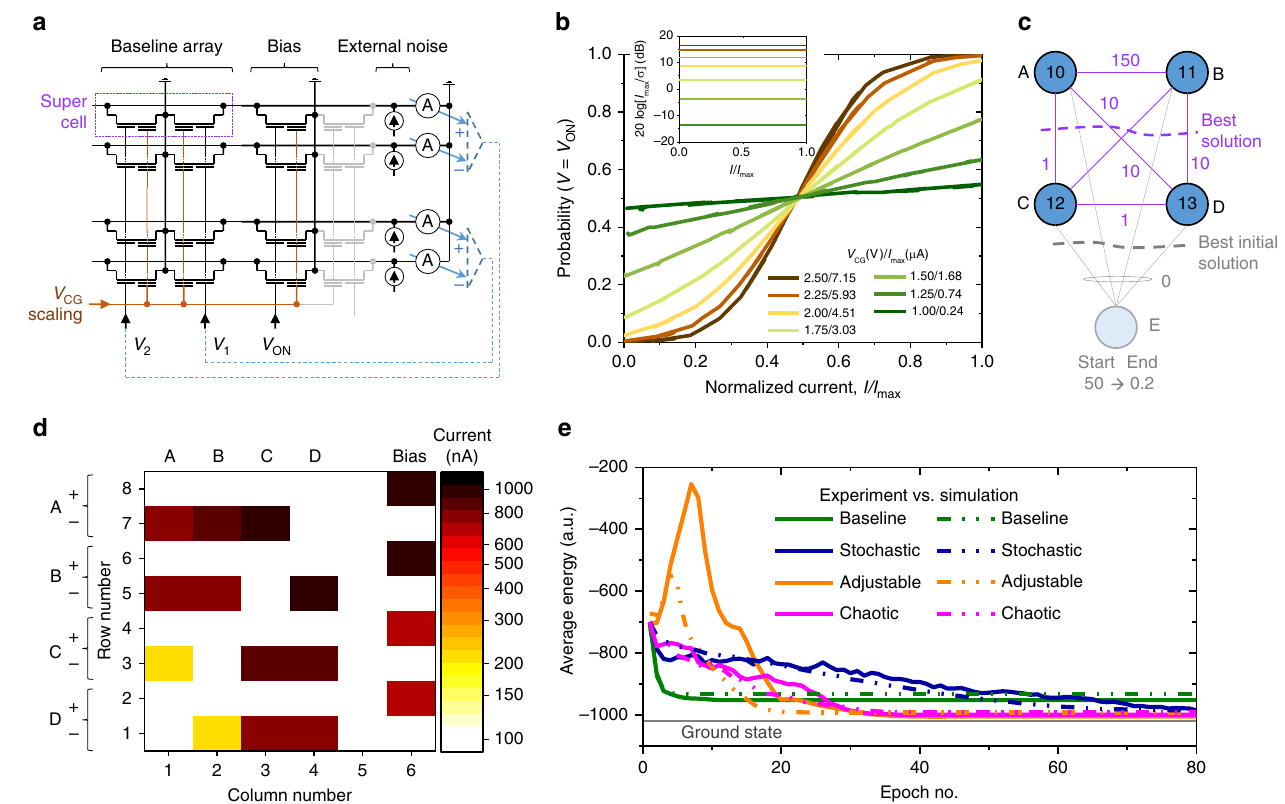
Fig. 3 Neurooptimization based on fl oating-gate memory arrays. a Schematics of the experiment, shown for clarity for the 2 × 2 supercell array implementing a baseline/stochastic network with two neurons. The parts shown with dashed lines were emulated in software. b Measured probability functions for single-ended stochastic neuron at various CG voltages (or effective computing temperatures). The inset shows measured peak SNR across the full range of neuron ’ s input currents. I max is the largest measured input current to the neuron. c Implemented graph-partitioning problem with considered edge and node weights. The wavy lines show the cuts corresponding to the best solution. Shaded nodes/edges are used for the method with dynamically adjusted energy function. d Conductance map for the main section (highlighted with blue background in Fig. 1e) of the weights in the experiment, after tuning with 3% precision. For the fi xed synaptic weights, the tuning was performed at the operating biases. For the variable weights, the tuning was performed at the lowest (largest) CG and WG voltages during operation for the stochastic (adjustable and chaotic) approaches. e Simulation and experimental results for neurooptimization. For the fi rst three (chaotic) cases, the data are averaged over 100 (20) runs for each of the initial state, with total of 1600 (320) runs. The energy function for “ adjustable ” case is calculated by taking into account only four original nodes. The biasing